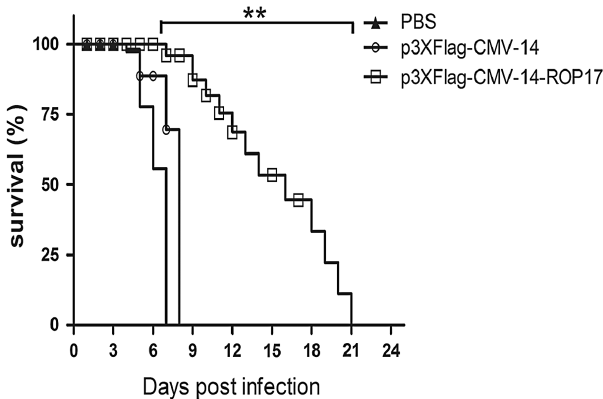
Figure 4. Protection of BALB/c mice against T. gondii acute infection. Survival curves of ROP17 DNA-immunized and control BALB/c mice were determined following lethal challenges with 1000 tachyzoites of virulent T. gondii RH strain at 2 weeks after the last immunization. Results are representative of two independent experiments and values are presented as means ± SD ( n = 10). ** P < 0.01 relative to the control